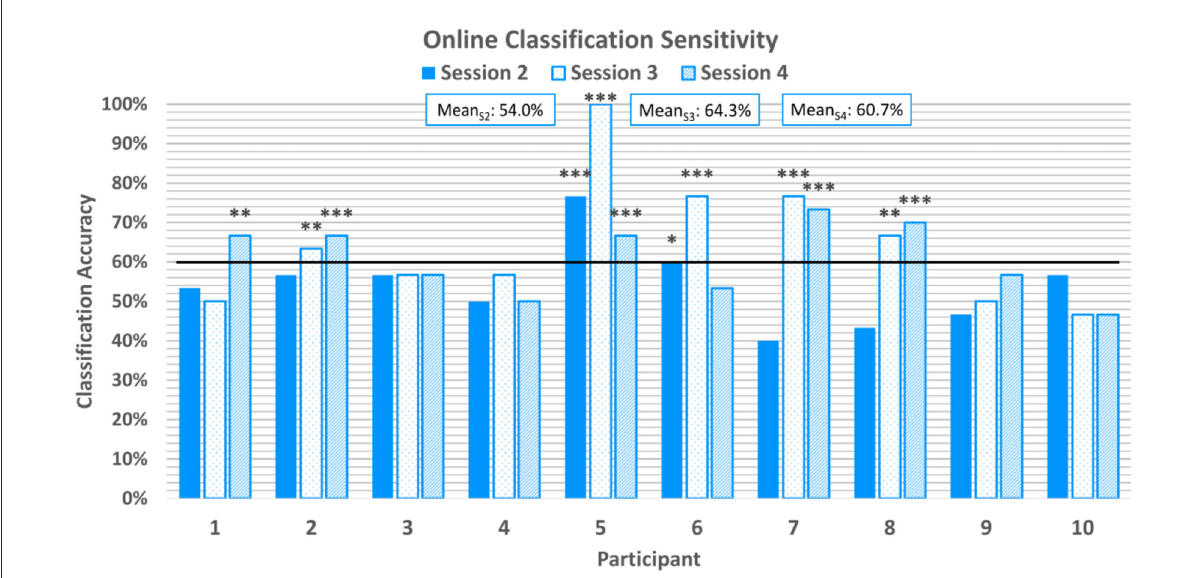
FIGURE6 Average classification sensitivity for each online session. Sensitivity refers to the correctly classified positive emotion-induction trials out of all positive emotion-induction trials. The horizontal line again represents the 95% confidence level threshold for the first online session. Sensitivities exceeding the upper limit of the 95%, 99%, and 99.9% confidence intervals of chance are marked with *, **, and ***,